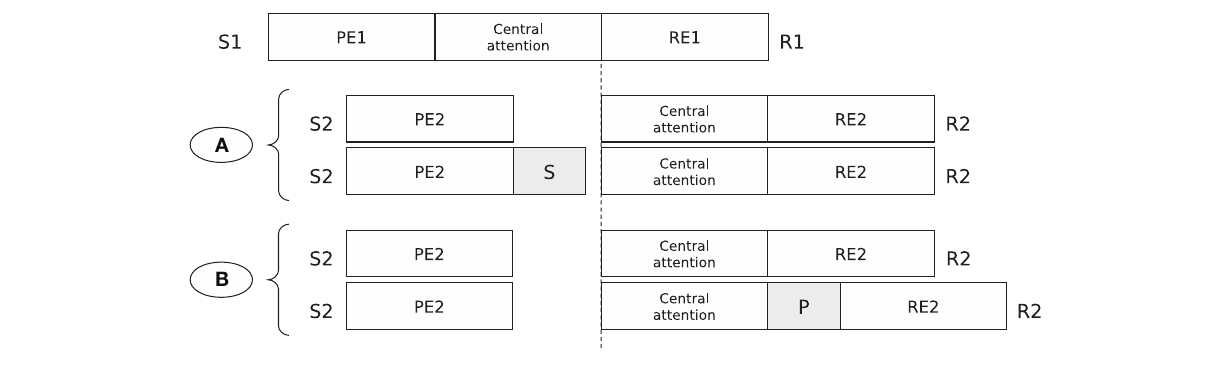
between SOA and semantic effects (shaded box labeled S) proposed in the present study. In the boxes, PE, perceptual encoding; RE, response execution. Numbers in the boxes are mapped to task order (1: Task1, S1 = tone, R1 = manual; 2: Task2, S2 = picture and word superimposed, R2 =